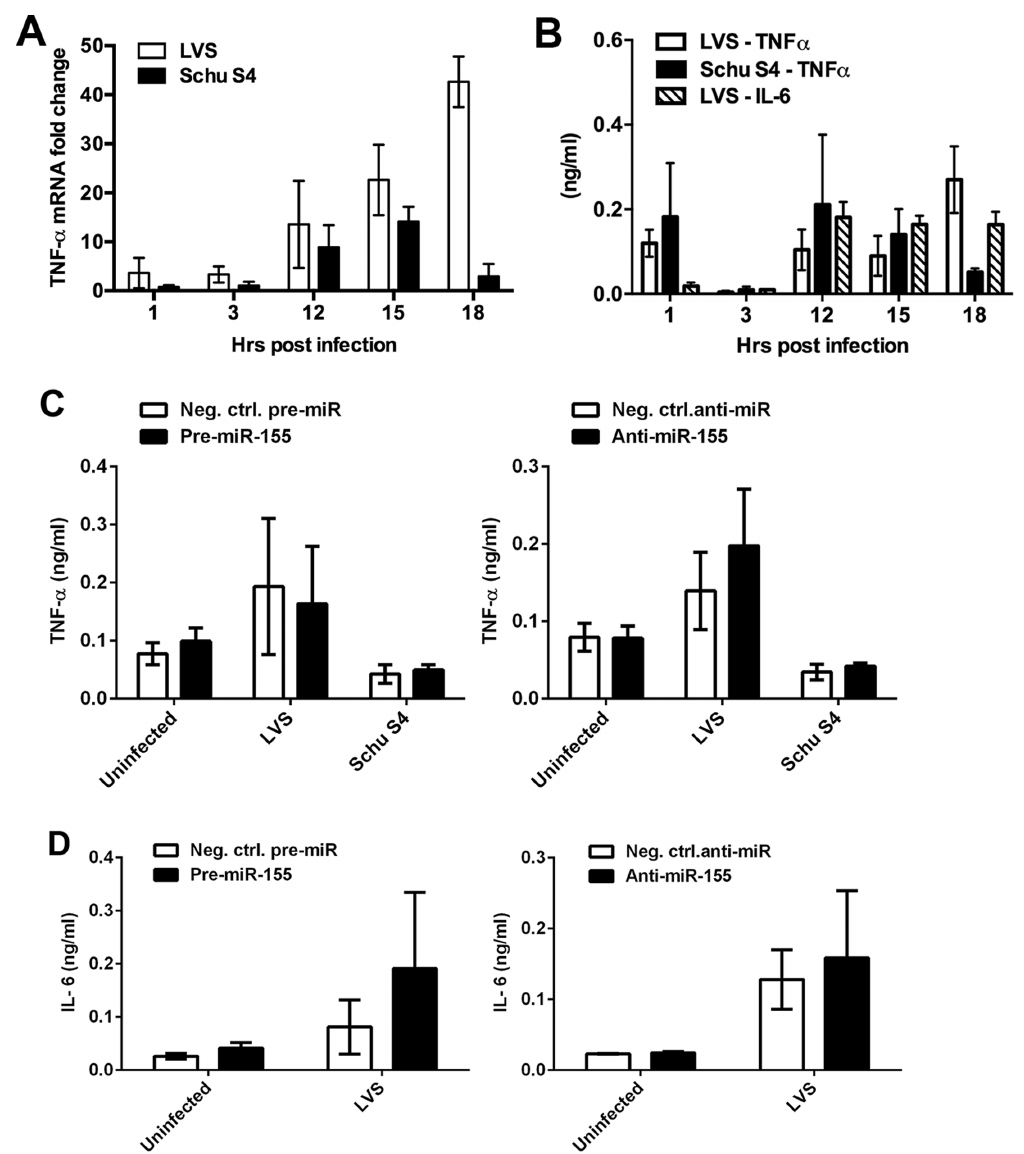
Figure 6. Manipulation of miR-155 does not significantly alter TNF a or IL-6 secretion triggered by F.tularensis infection. A . Effects of LVS and Schu S4 on TNF a mRNA expression were analyzed by qRT-PCR. Data shown are the mean 6 SEM (n=3) and were normalized to GAPDH. B . MDMs were infected with LVS or Schu S4, and secreted TNF a and IL-6 were quantified at the indicated time points by ELISA. Data shown are the mean 6 SEM (n=3). C–D . MDMs were transfected with the indicated pre-miRs and anti-miRs 48 h prior to infection with LVS or Schu S4, as indicated. At 24 h post-infection the amount of TNF a (C) and IL-6 (D) secreted into the extracellular medium was quantified by ELISA. Data shown are the mean 6 SEM